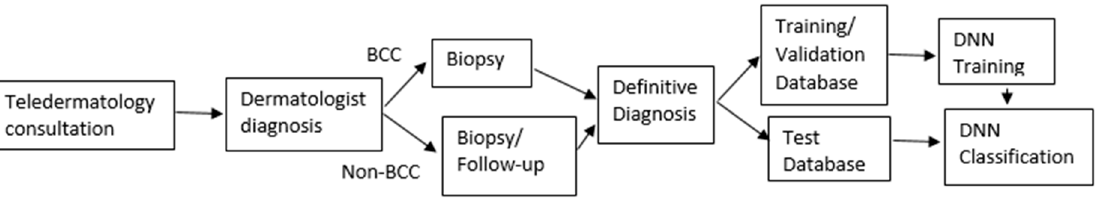
Figure 7. Flow diagram followed by the participants in the four tests analyzed in this